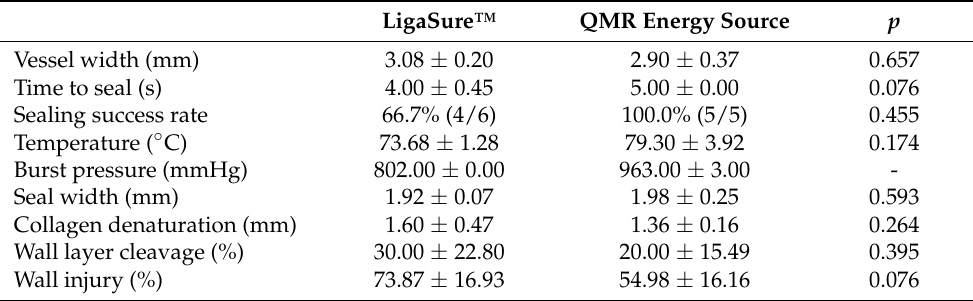
Table 2. Evaluated parameters and histological analysis for ligated aortas. LigaSure™ QMR Energy Source Vessel width (mm)